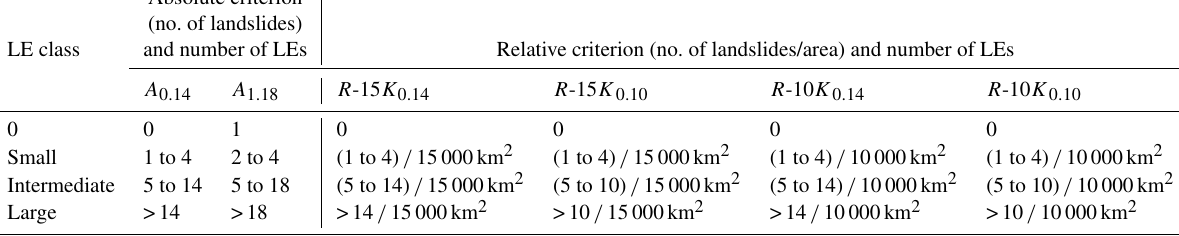
Table 6. Parametric analysis: landslide density criteria considered to classify the LEs. Absolute criterion